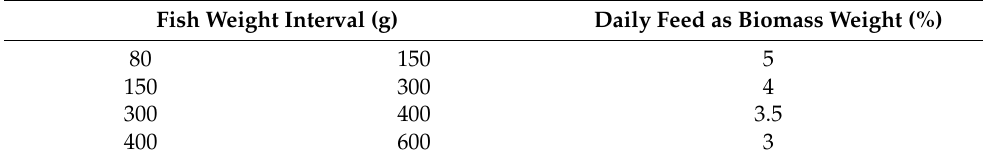
Table 2. Daily feed rations offered according to fish biomass. Fish Weight Interval (g) Daily Feed as Biomass Weight